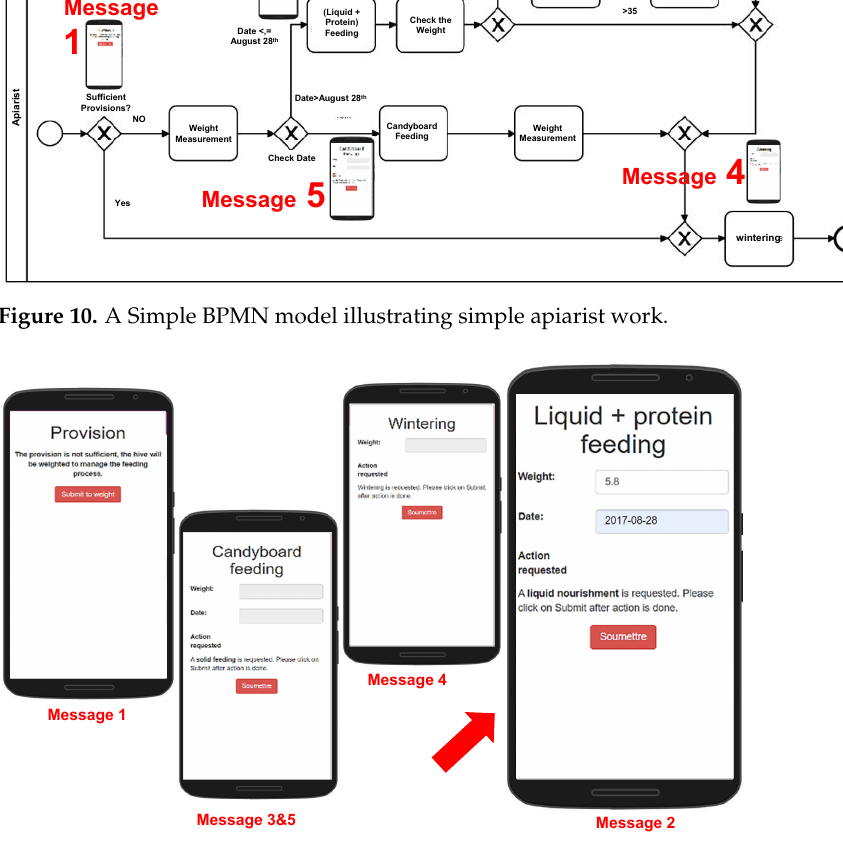
Figure 11. Showing messages 1,2,3,4 and